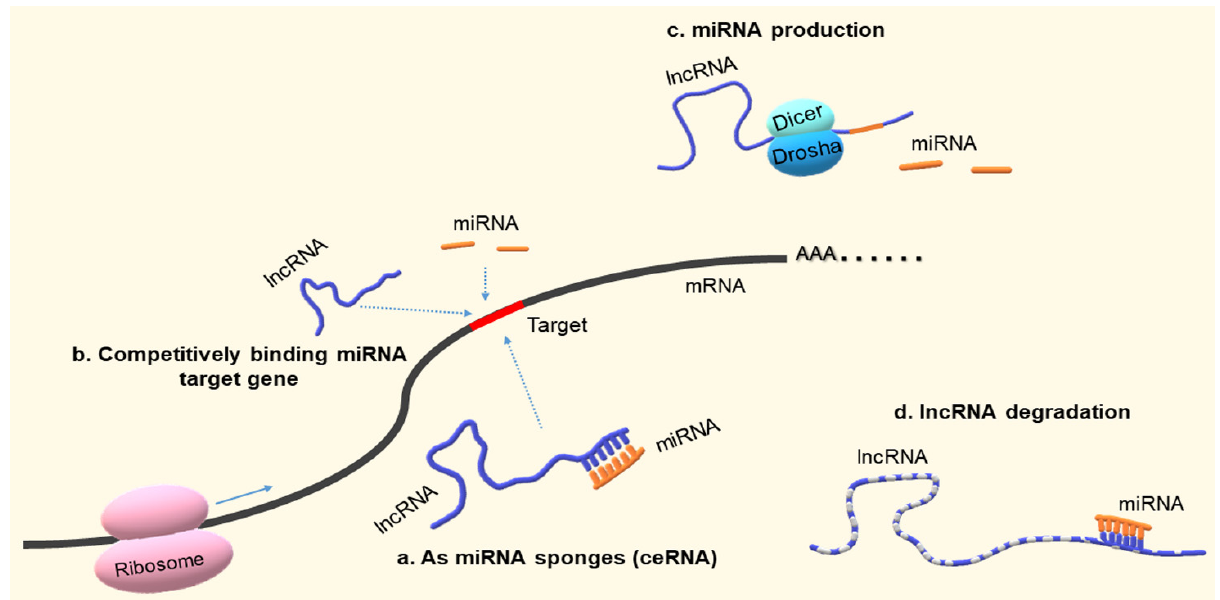
Figure 1. The biological functional relationship between long non-coding RNA and microRNA. lncRNA, long non-coding RNA; miRNA, microRNA; ceRNA, competing endogenous RNA.